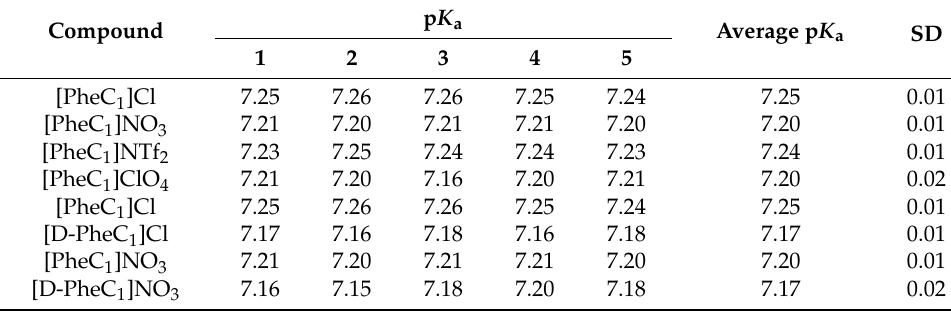
Table 2. The p K a values of [AAE]X with di ff erent anions and cations.